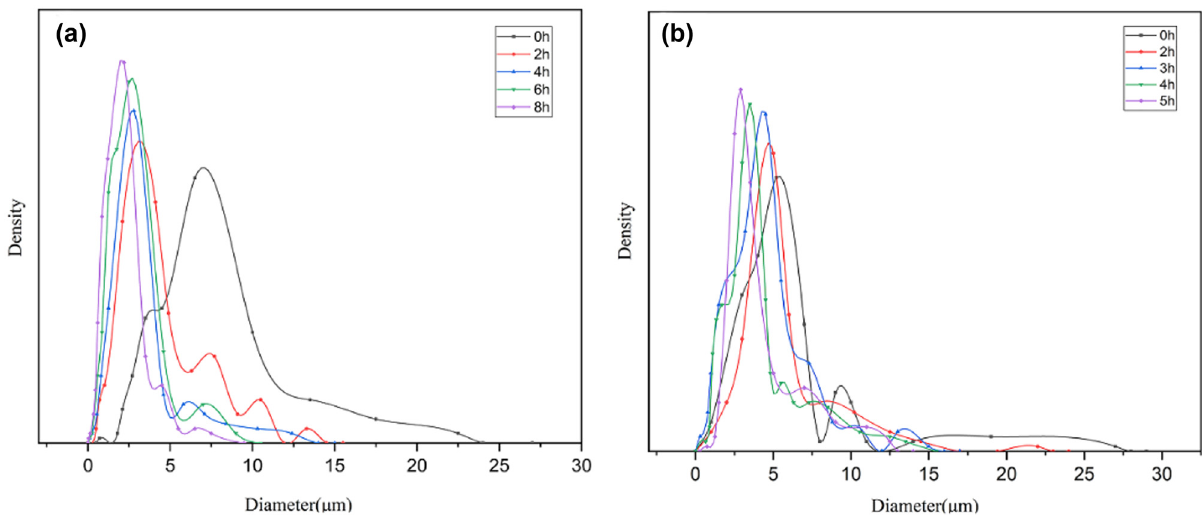
Figure 4: Particle size distribution of plant cell walls at di ff erent milling times: ( a ) tobacco stem and ( b ) tobacco